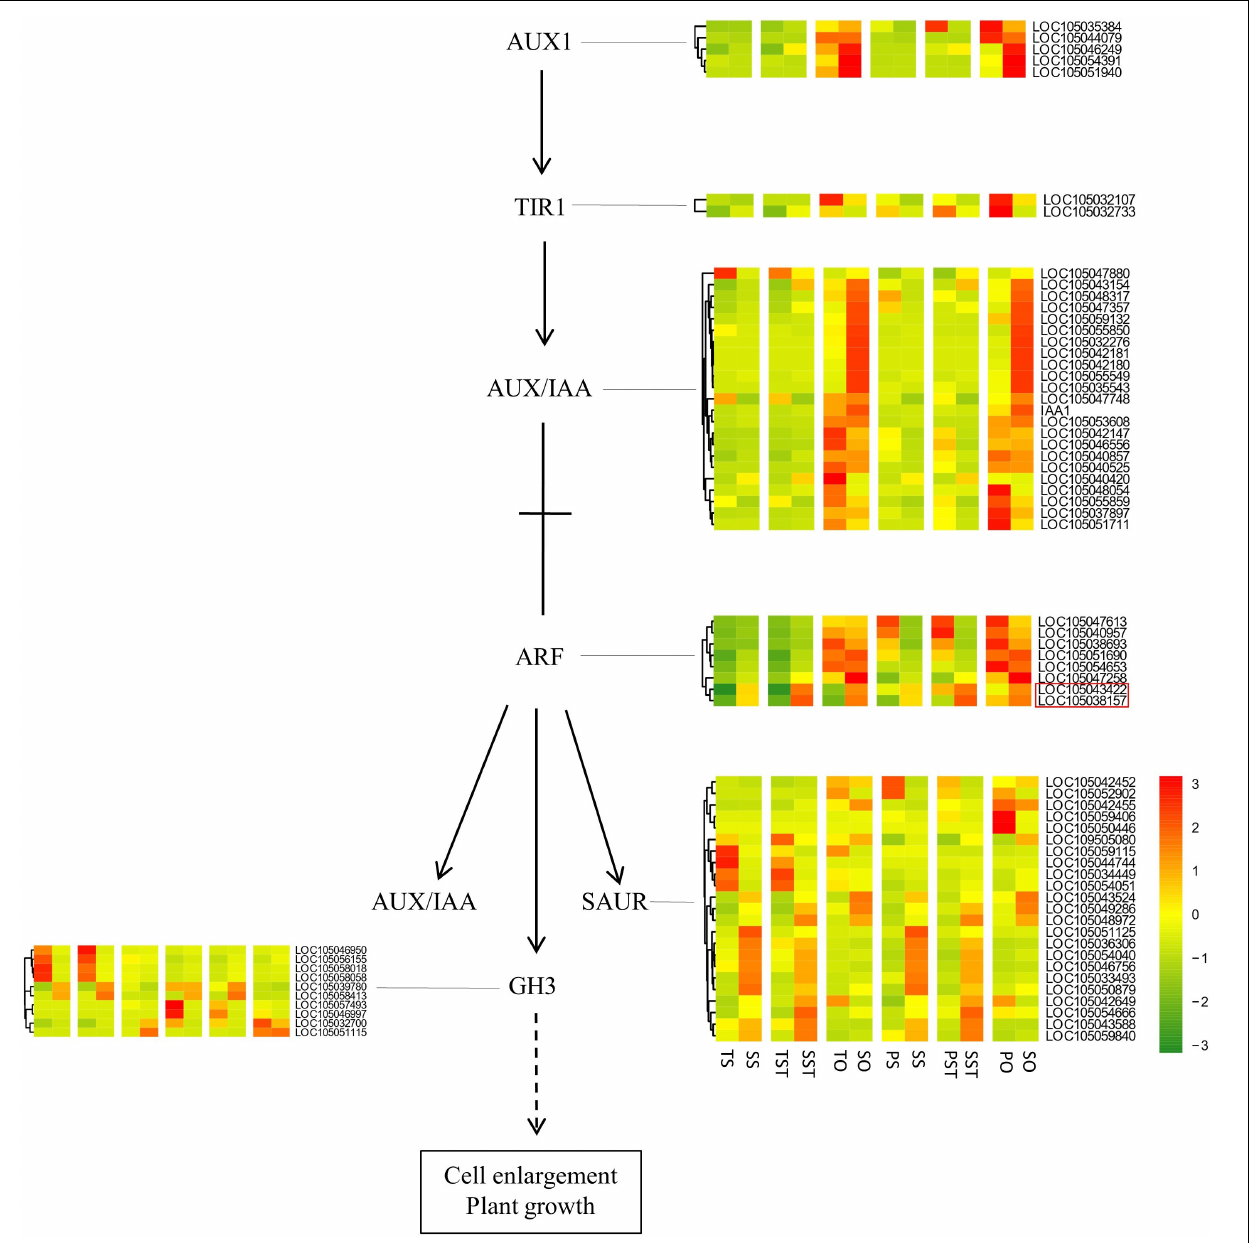
FIGURE 9 | Analysis of the genes in auxin signaling pathway. Red box indicates ARF genes up-regulated in Seedless palm trees (S) compared with Tenera (T) and Pisifera (P).